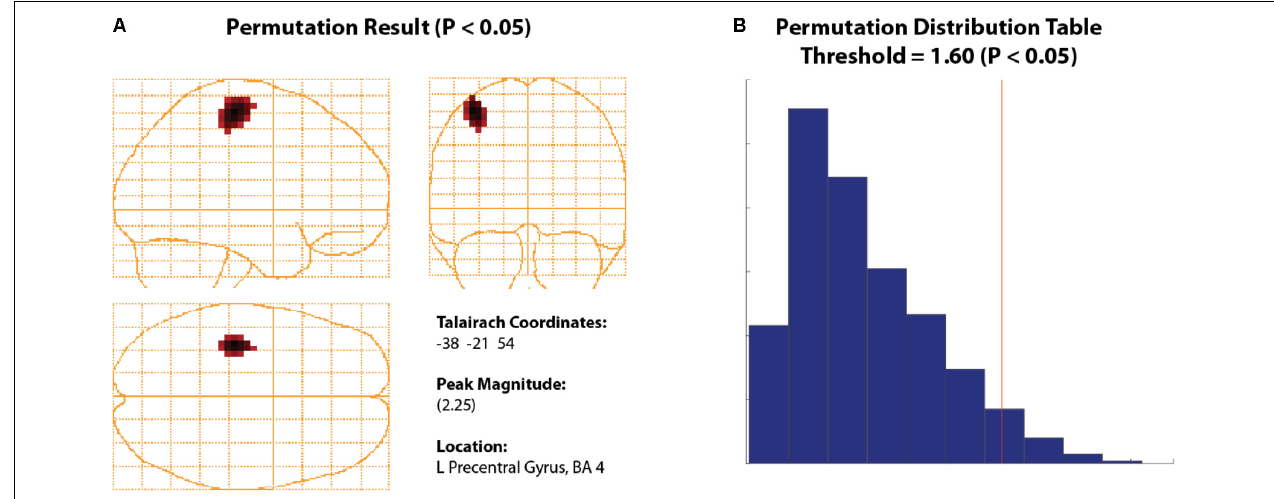
FIGURE 7 | Permuted Beta Suppression Peak. (A) Significant beta rebound peak with all voxels shown with a significance of P > 0.05 or higher. (B) The significance cut-off was determined using a permutation distribution plot which calculated all significant values to the right of the red vertical